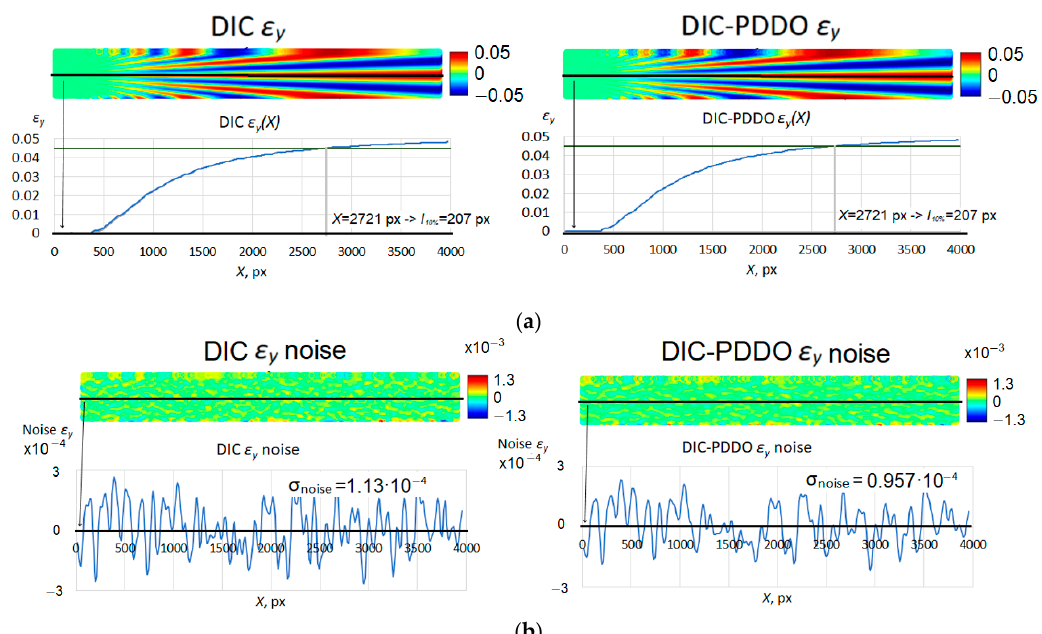
Figure 10. DIC and DIC-PDDO strain computation methods comparison using MEI: ( a ) strain fields showing the same spatial resolution of both methods for the DIC VSG = 81 px and PD 2 δ = 140 px, ( b ) measurement resolution showing 1.2 times lower noise standard deviation in DIC-PDDO strains.